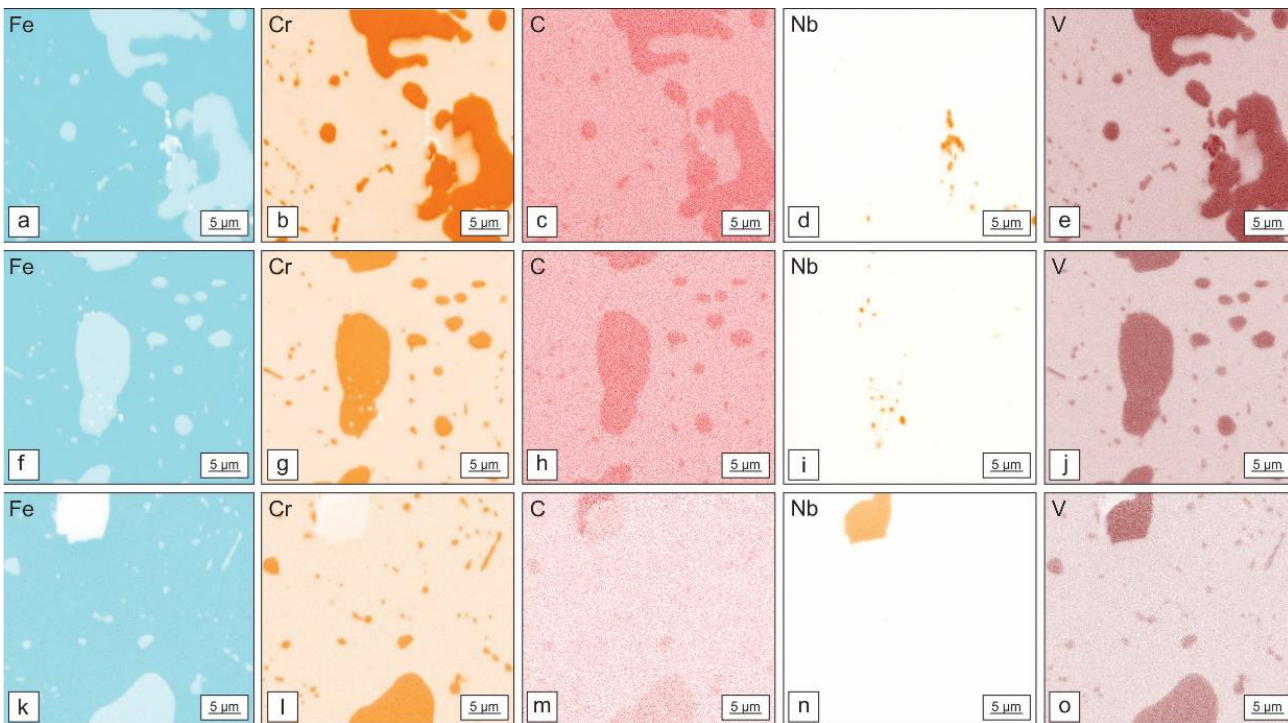
Figure 5. EDS-mapping of all three samples: CHT ( a – e ), SCT ( f – j ) and DCT ( k – o ) for Fe, Cr, C, Nb and V.